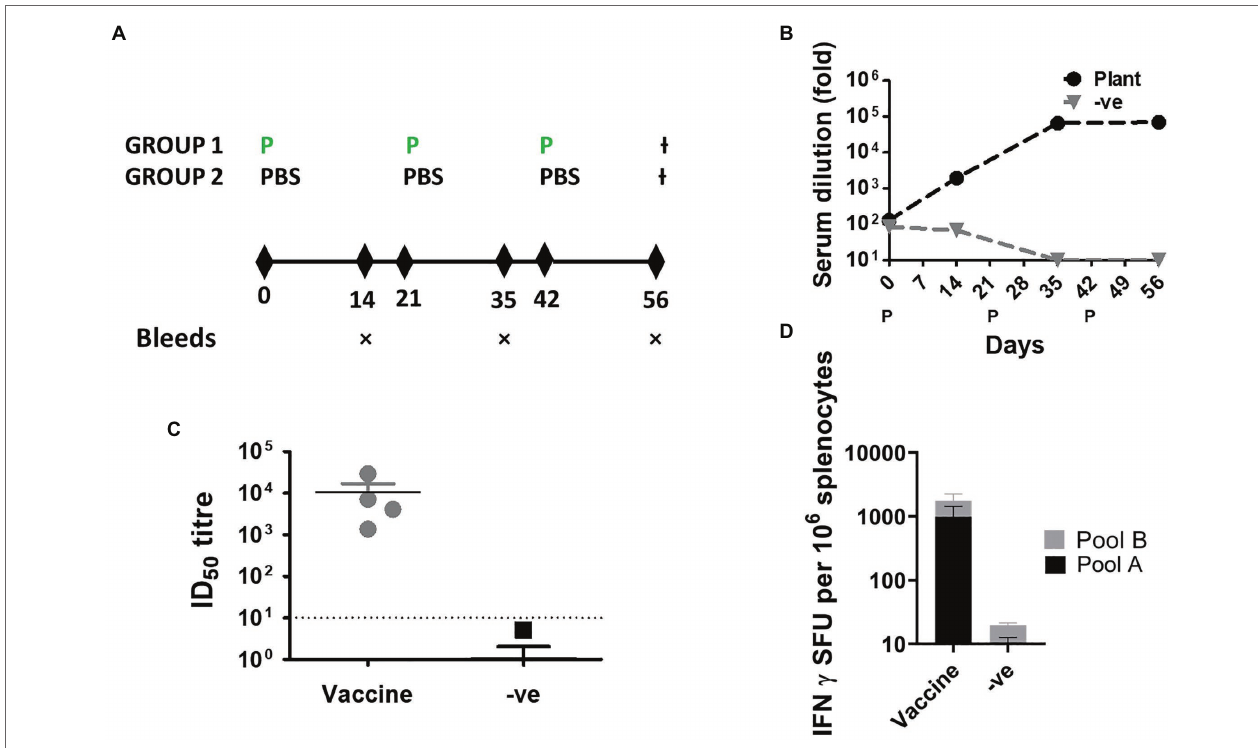
FIGURE 3 | Immunogenicity of SARS-CoV-2 S ∆ TM in BALB/c mice. (A) Schematic of the timing of immunizations and blood draws. Animals were inoculated with the purified antigen on days 0, 21, and 42. Blood was drawn on days 14, 35, and 56. The experiment was terminated on day 56. (P, protein immunization; − ve, PBS formulated with adjuvant). (B) Quantification of serum-binding antibodies by ELISA over the course of the experiment. The antibody titers are presented for pooled sera at each time point. (C) Terminal neutralizing antibody titers against the matched virus from which the vaccines were derived. (ID 50 , half maximal inhibitory